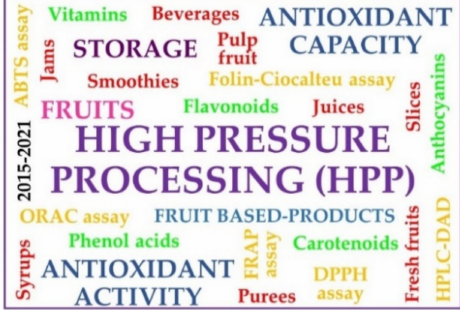
Figure 1. Target keywords of the